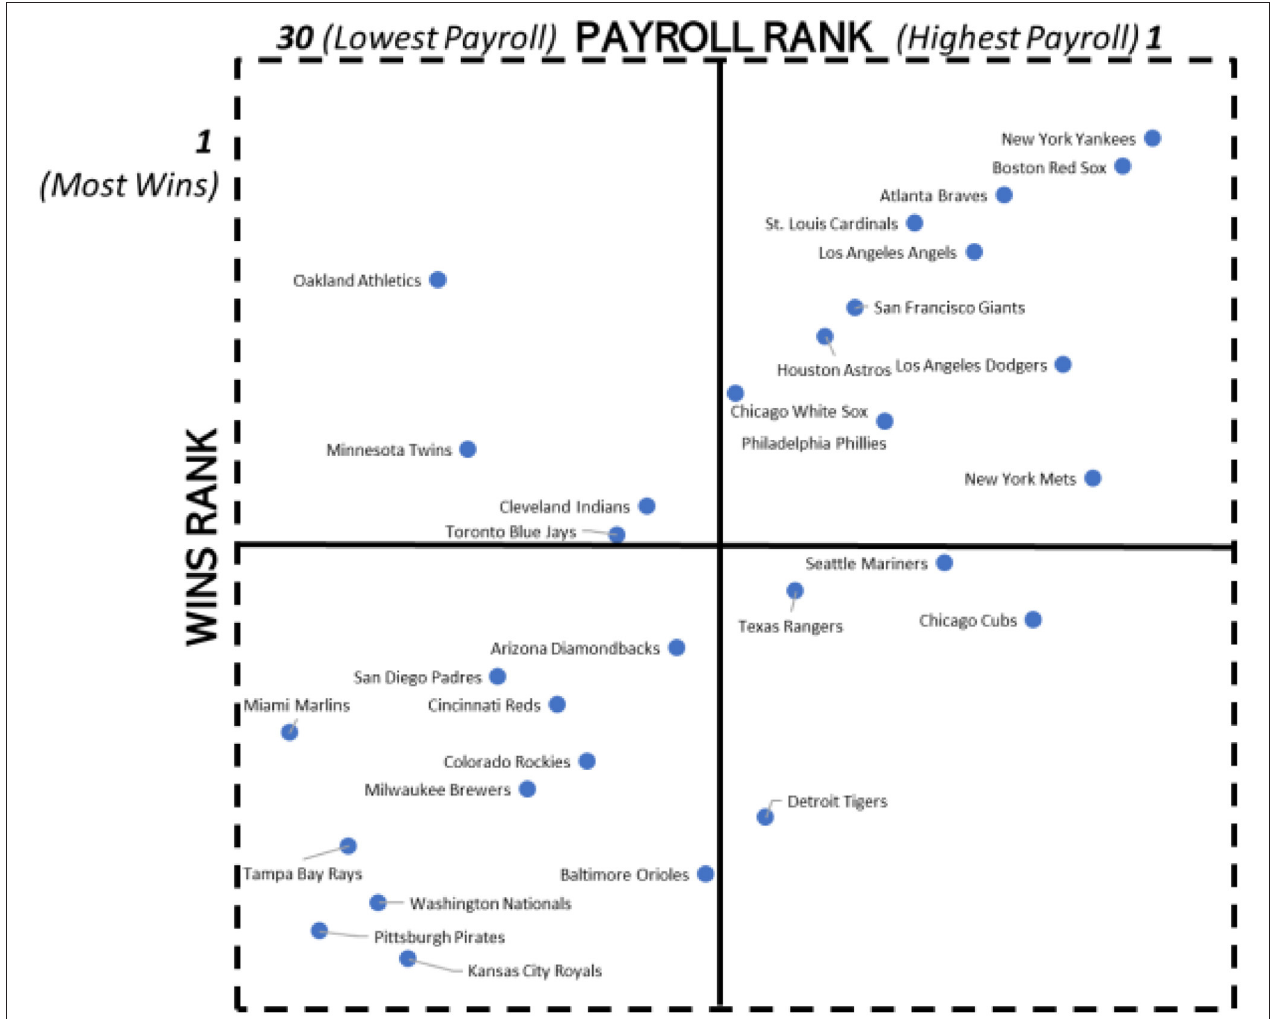
FIGURE 5 | Quadrant analysis of MLB payroll rank and regular season win percentage ranks: 1998–2010.